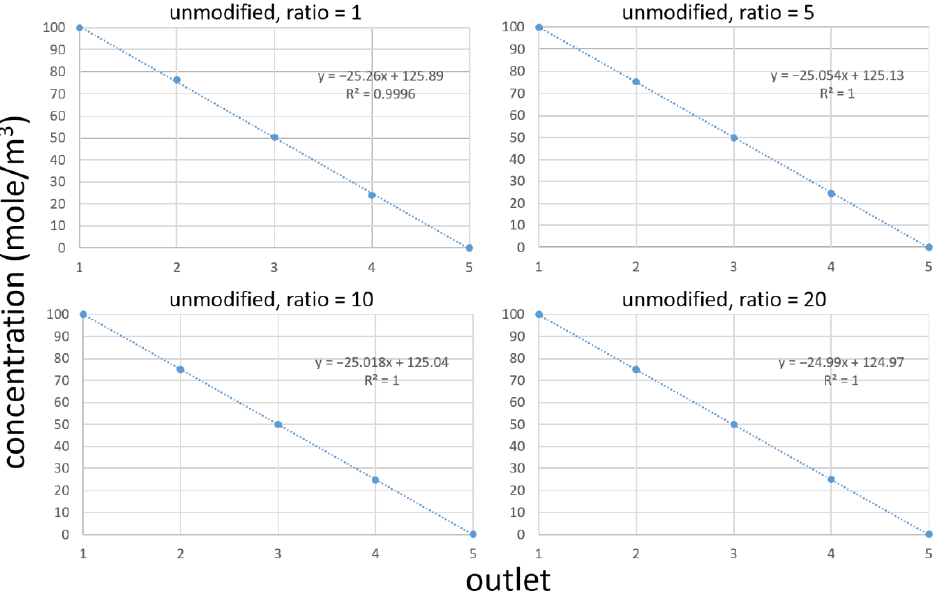
Figure 10. Simulation of chemical concentrations for unmodified devices with different ratios of R V / R H .